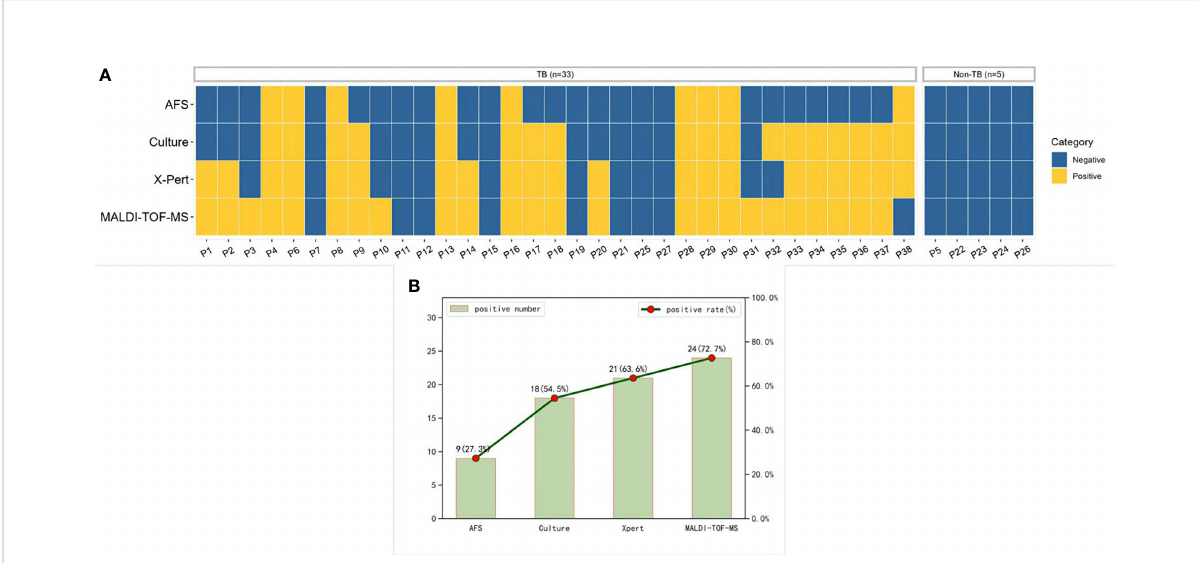
FIGURE 3 MTB results detected by multiple methods. (A) A heatmap depicting the identi fi cation of MTB in BALF samples by different methods. (B) Positive rates of each method in patients diagnosed with pulmonary tuberculosis. MTB, Mycobacterium tuberculosis; BALF, Bronchoalveolar lavage fl